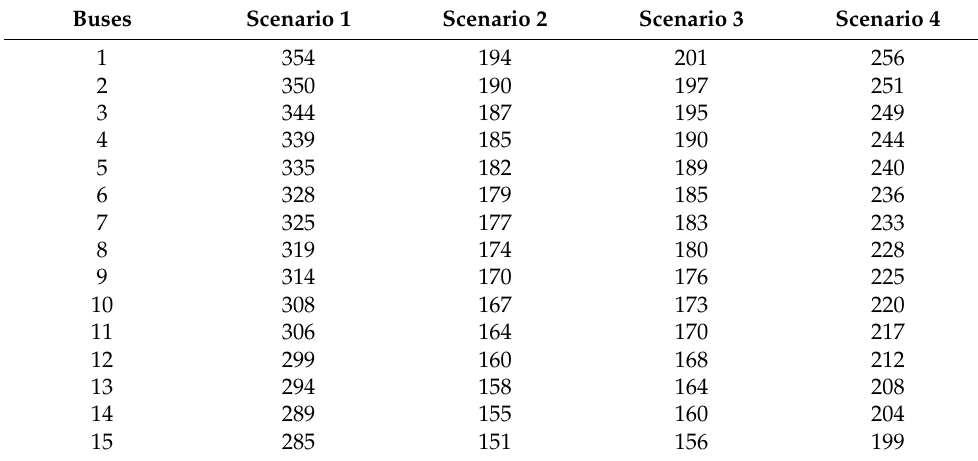
Table 3. Departure times of buses from stop 1 in each scenario.